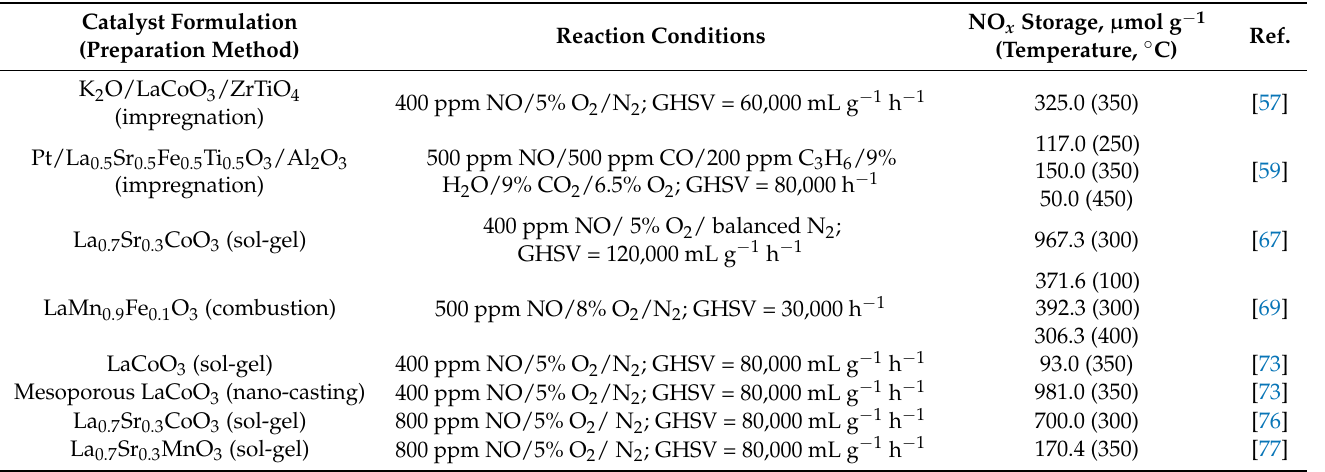
Table 1. Review of NO x storage capacity of the La-based